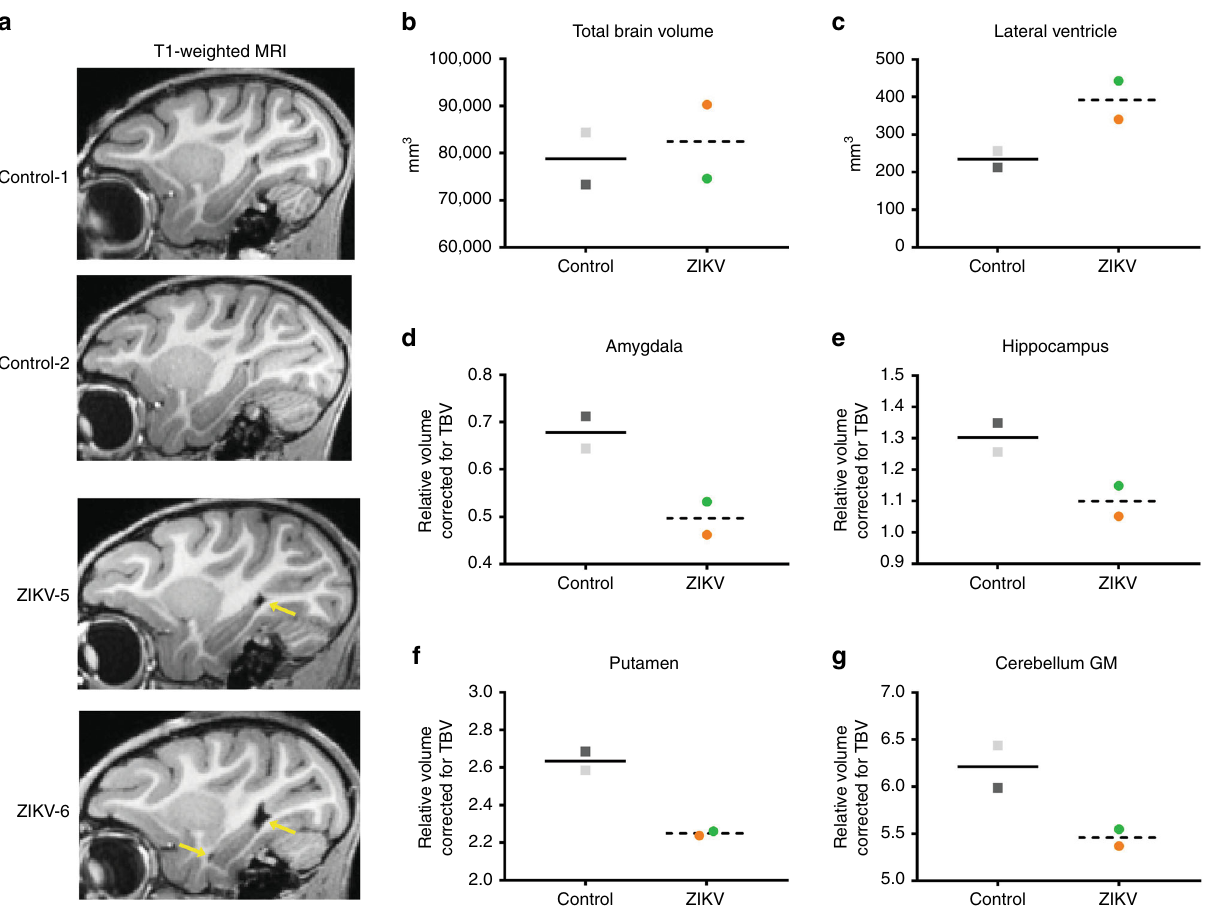
Fig. 3 Postnatal ZIKV infection leads to ventricle enlargement and reduced subcortical volumes. a Sagittal T1-weighted structural MRI images through the hippocampus; yellow arrows illustrate the increased lateral ventricle volume in ZIKV-infected RMs. Volumetric measurements of b the total brain volume and c lateral ventricles in cubic millimeters, as well as d amygdala, e hippocampus, f putamen, and g cerebellum gray matter (GM) corrected by total brain volume. The correction used was speci fi c brain region/TBV × 100. ZIKV-infected infant RMs are represented by dashed line with circles (green = ZIKV-5 and orange = ZIKV-6) and controls are represented by solid line with squares (dark gray = Control-1 and light gray =